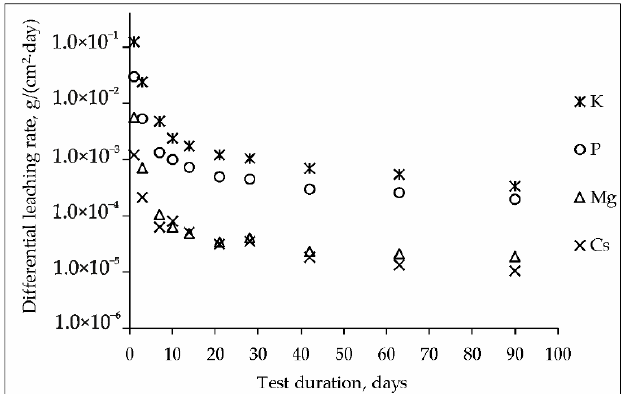
Figure 3. Kinetic curves of the leaching rate of elements from the MPP compound containing CsCl (test GOST R